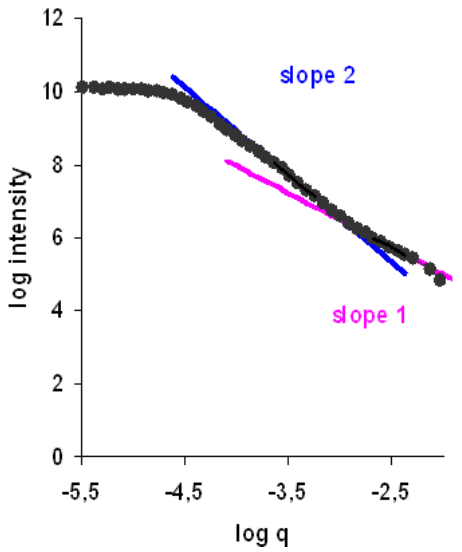
Figure 1. Scattering pattern of an aggregate (slope 1—d 2sin4  n   0  q  , with n the refractive index of the dispersing medium,  the scattering 0 0 angle and  the incident light wavelength in 0